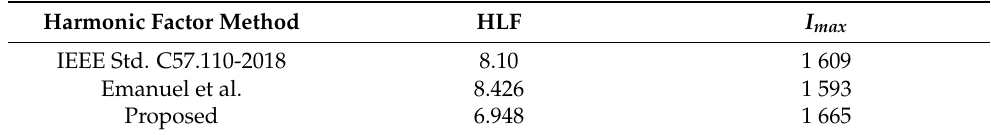
Table 12. Harmonic loss factor comparison.